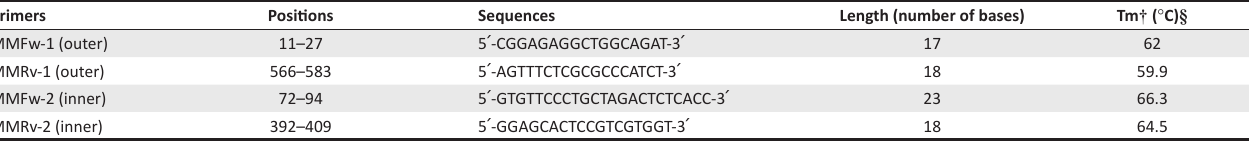
TABLE 1: Designed primers used for the in-house nested human immunodeficiency virus-2 polymerase chain reaction and sequencing.